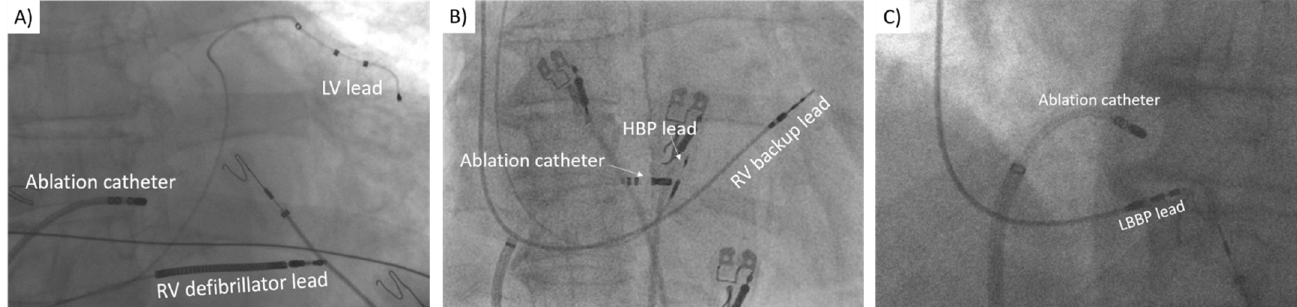
Figure 1. Fluoroscopic view of the ablation catheter in relation to biventricular pacing ( A ), His bundle pacing ( B ) and left bundle branch pacing ( C ) lead.